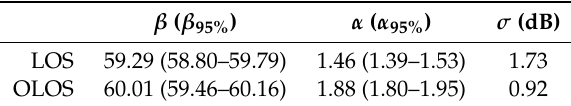
Table 2. FI path loss model parameters.